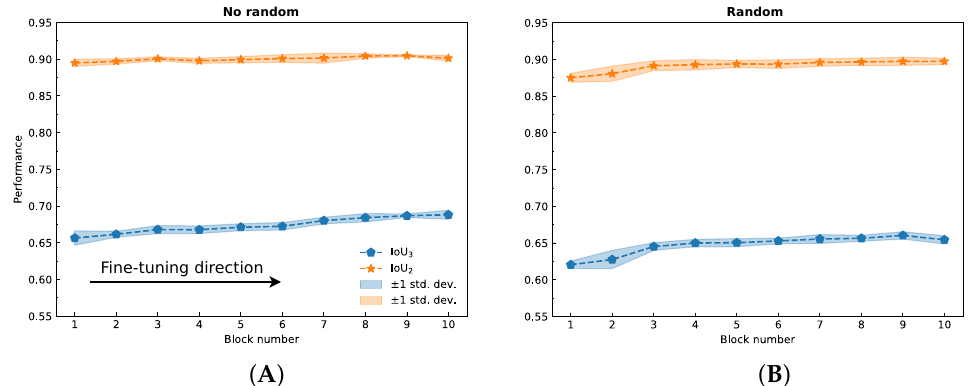
Figure 4. Average IoU 3 and IoU 2 scores depend on the number of trainable blocks in the EfficientNet- B7 encoder. The arrow shows the direction of the fine-tuning blocks: from the first to the last. ( A ) With fine-tuning, the block weights are not reset. Achieved performance: IoU 3 = 0.703 ± 0.005 and IoU 2 = 0.83 ± 0.01. ( B ) With fine-tuning, the weights of trainable block are reset. Achieved performance: IoU 3 = 0.538 ± 0.004 and IoU 2 = 0.804 ±